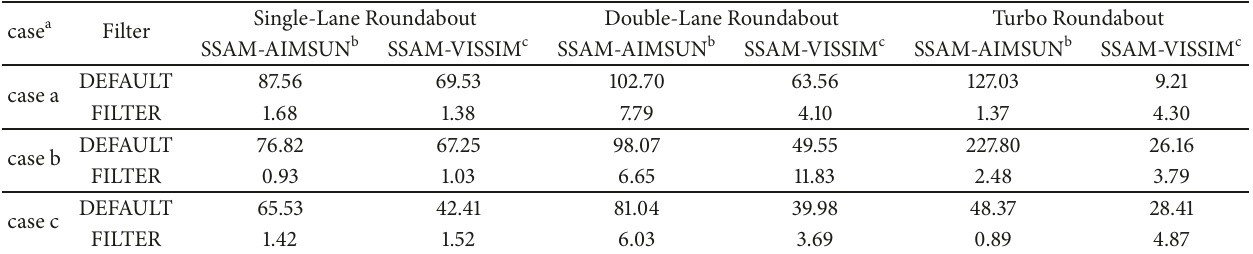
Table 6: Normalised total conflicts at